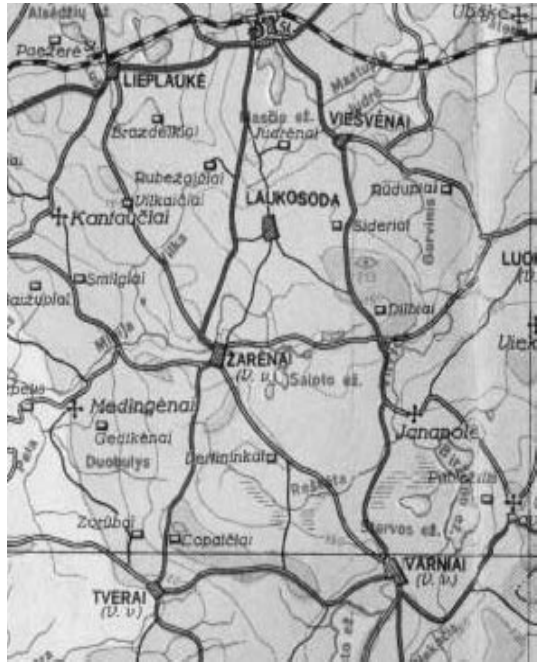
Fig 3. Fragment of hidrographic map of river basins of Lithuania. 1:1 000